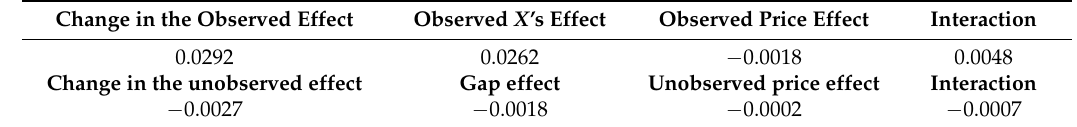
Table 7. Juhn-Murphy-Pierce decomposition method (Stage